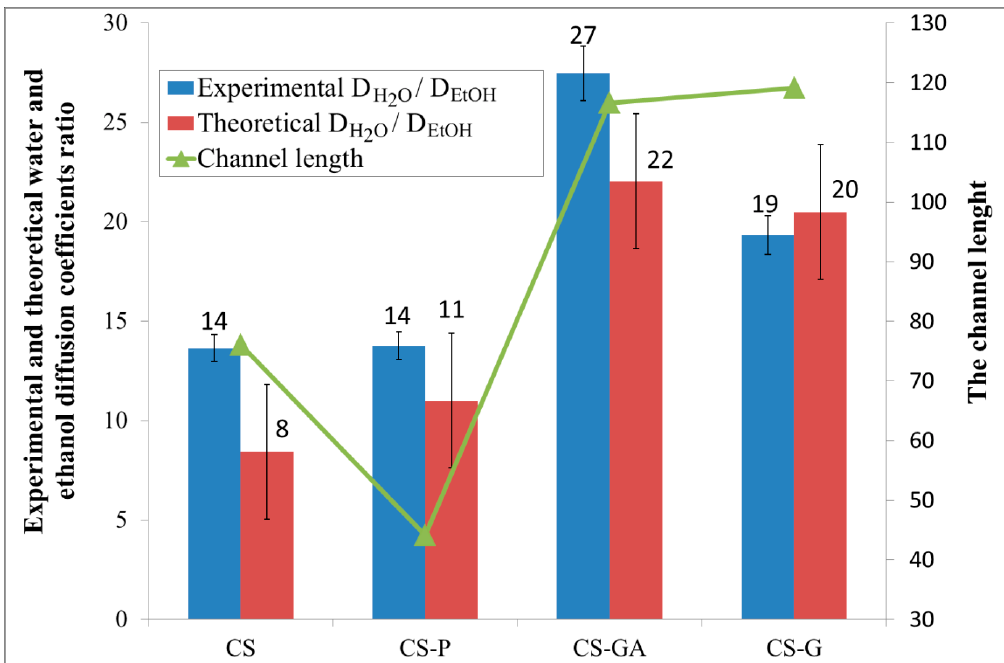
Figure 8. Comparison of the intercorrelations between the experimental data and the results obtained from the fractal and random walk analysis of the alginate membranes filled with neat chitosan (CS) and modified CS microparticles; phosphorylated chitosan (CS ‐ P), glutaraldehyde crosslinked chitosan (CS ‐ GA), and glycidol ‐ modified chitosan (CS ‐ G).